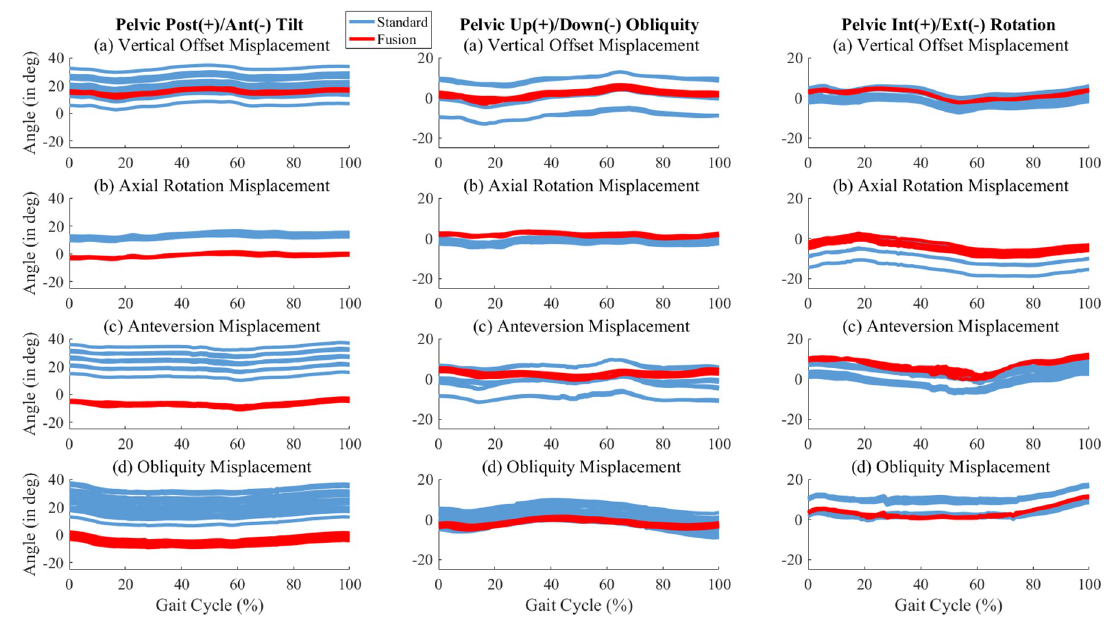
Fig 4. Pelvis kinematics, standard method versus fusion method. The marker misplacements are as follow: (a) Vertical Offset, (b) Axial Rotation, (c) Anterversion, (d) Obliquity.